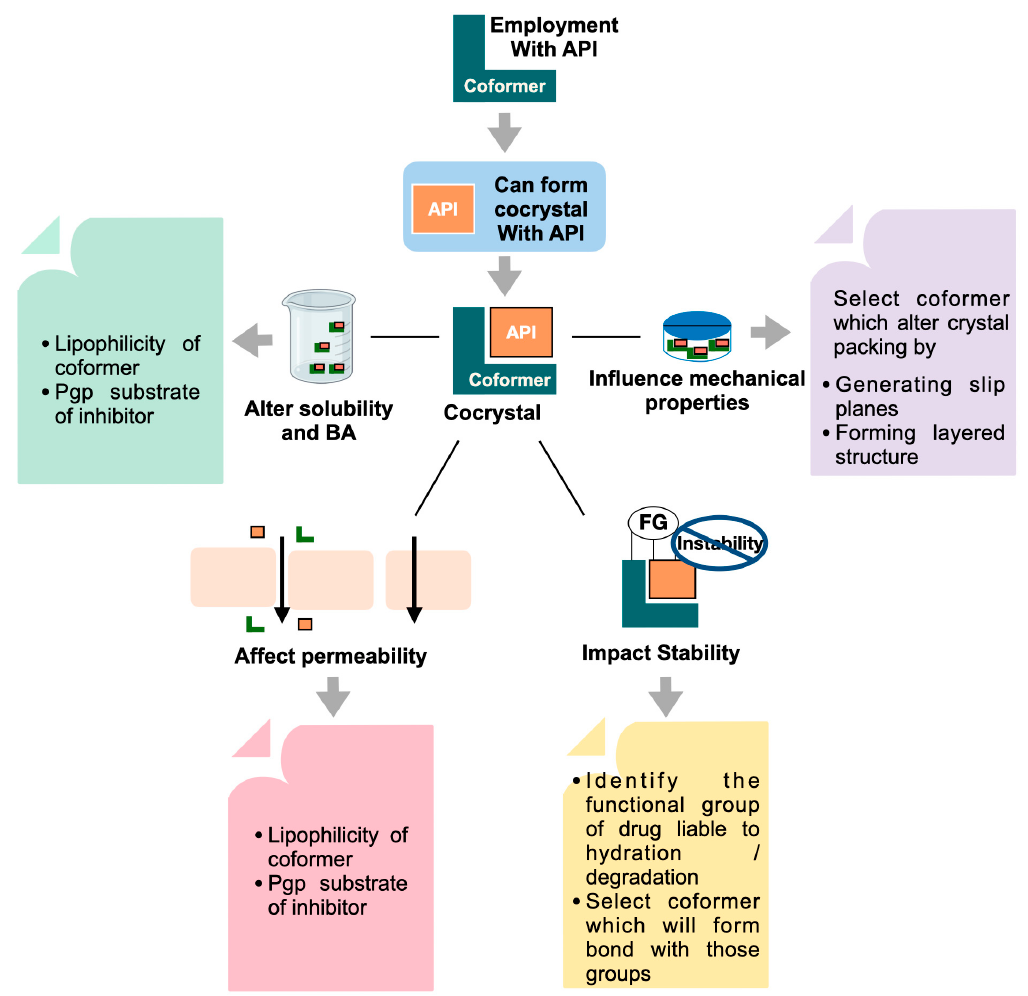
Figure 4. Pharmaceutical attributes affected by cocrystal formation and its relation to coformer properties.